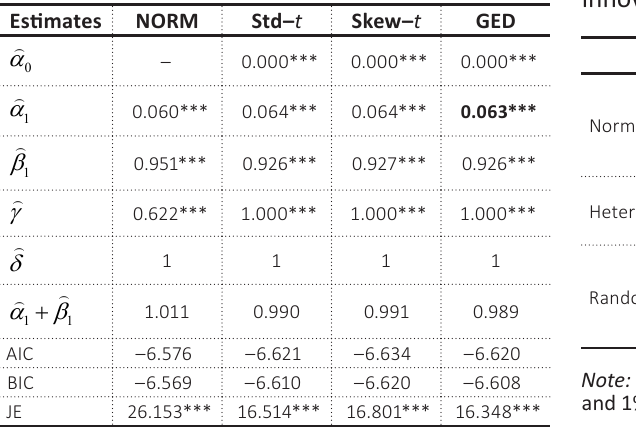
Table 6. ML parameter estimates of APARCH with different innovation distributions Table 7. Preliminary test results for